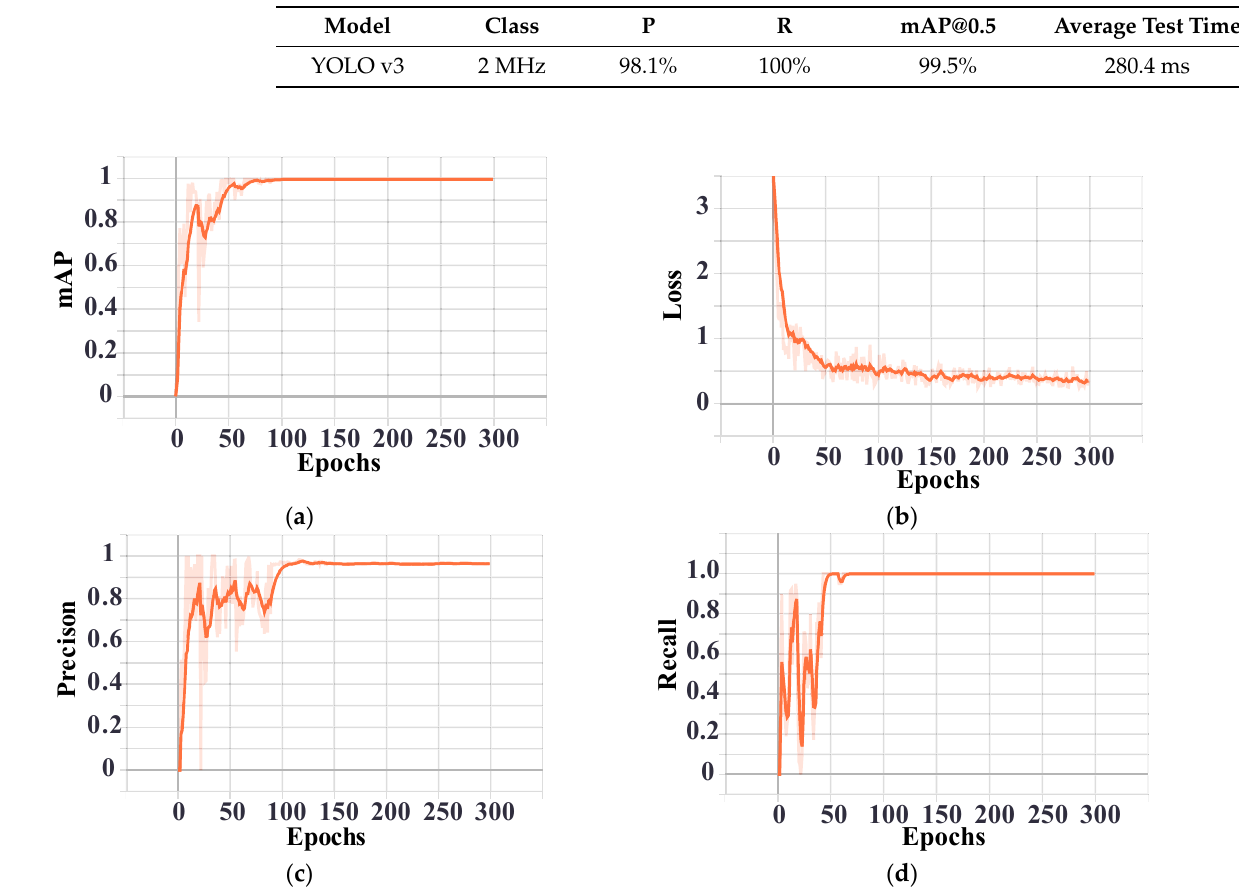
Figure 10. ( a ) mAP, ( b ) loss, ( c ) precision, and ( d ) recall of YOLO v3.